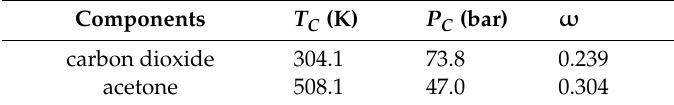
Table 1. Critical properties and acentric factors for pure components.